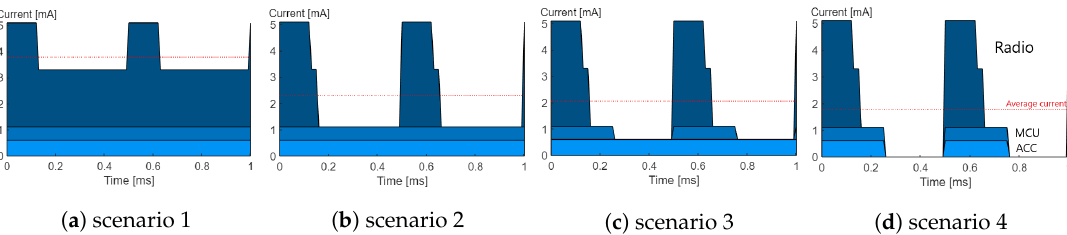
Figure 14. Putting the radio (dark blue), microcontroller unit (MCU) (blue) and accelerometer (ACC) (light blue) in sleep mode can have an extensive current consumption reduction. Increasing the duty cycle will increase the reduction even more. The current when all three components are in sleep mode will be the lowest possible current and determines the feasibility of the node. The radio has three states (TX-idle-sleep), MCU en ACC has two states